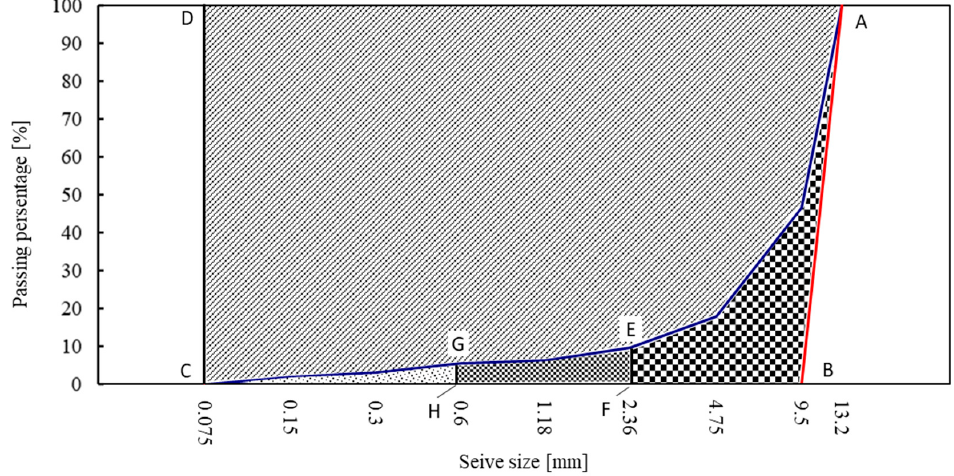
Figure 5. Schematic diagram of the determination of aggregate breakage potential.